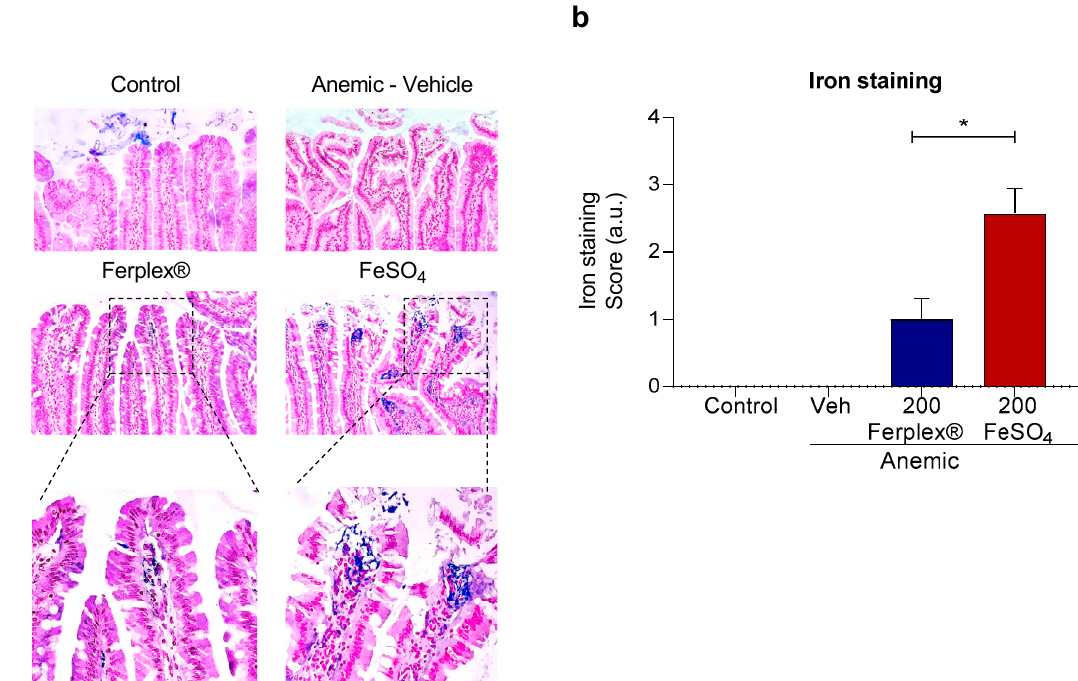
Figure 7. Histological analysis of iron deposition. ( a ) Representative image of Prussian blue staining of the duodenal sample, showing localization of blue iron staining in the lamina propria at 200x magnification. ( b ) Quantification of iron deposition as a score of non-luminal iron staining. * p < 0.05 with the Mann-Whitney test. N = 6 (anemic-vehicle); 8 (control); 7 (treatment groups). Veh = vehicle.